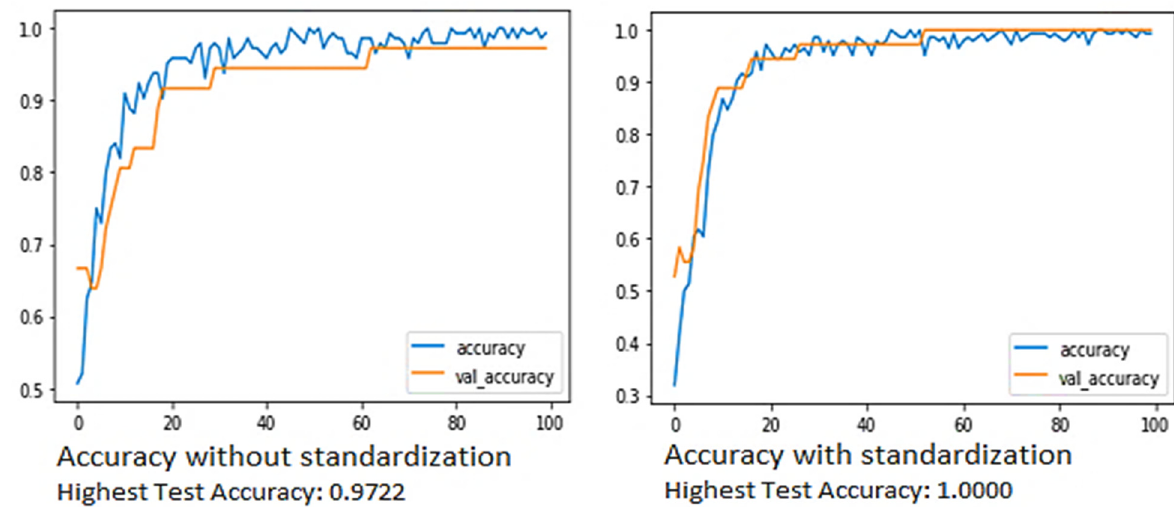
Figure 10. Accuracy curve without and with standardization.